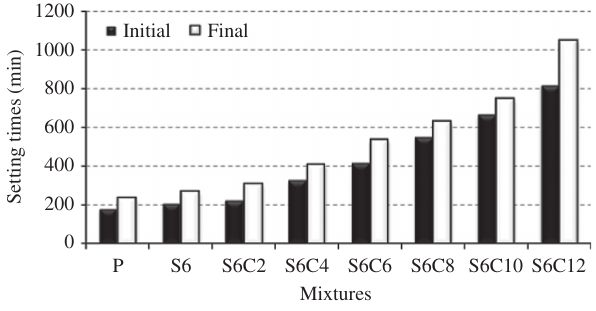
Figure 1 Microstructure of 42.5 N Portland cement.